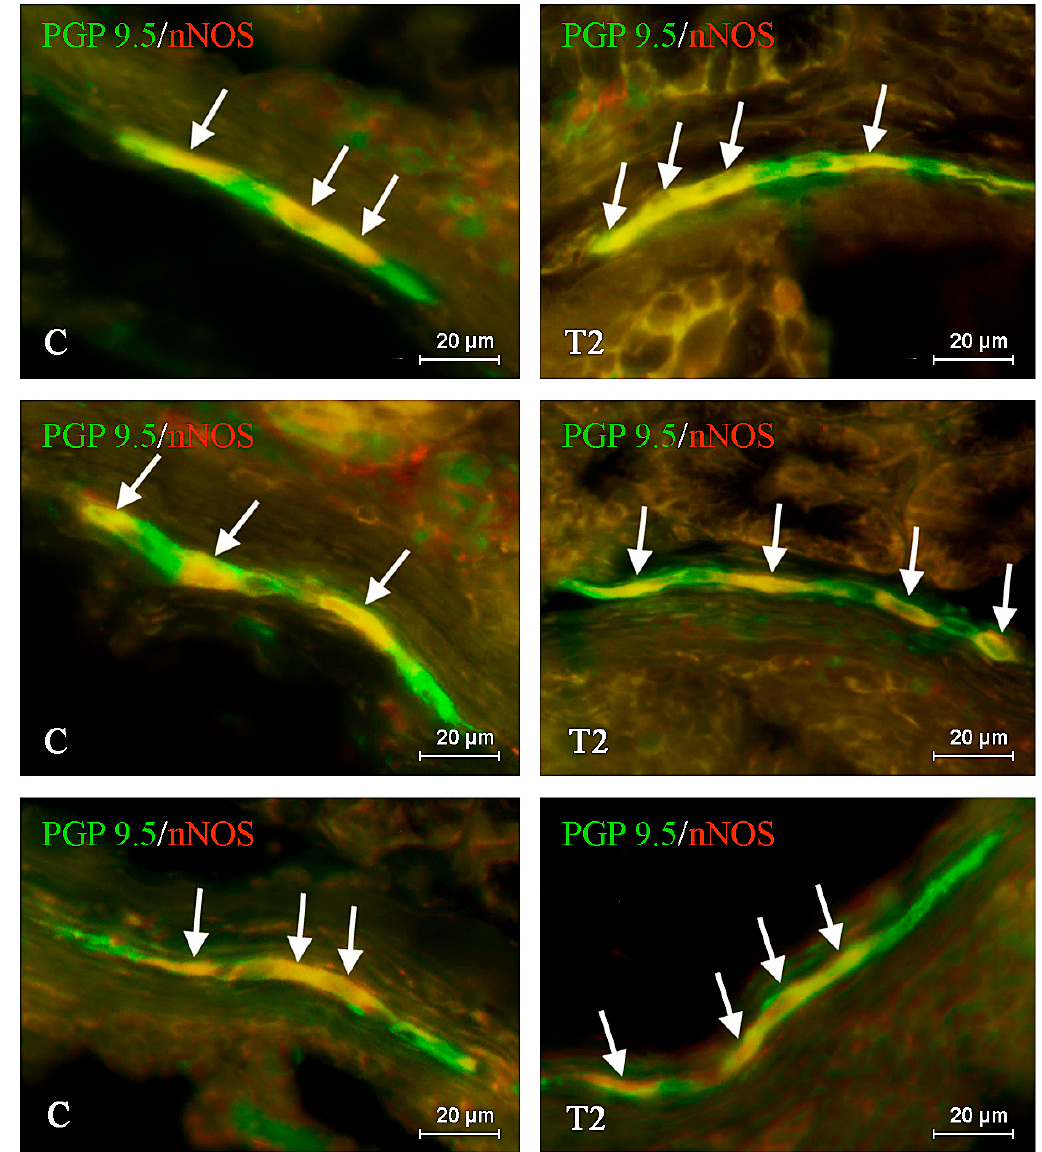
Figure 3. Distribution pattern of nerve cells immunoreactive to protein gene-product 9.5 (PGP 9.5)—used as pan neuronal marker and neuronal isoform of nitric oxide synthase (nNOS) in the inner submucous plexus of porcine duodenum under physiological conditions (C) and after T2-toxin administration (T2); the pictures are the result of the overlap of both stainings. The arrows are pointing neurons immunoreactive for both—PGP 9.5 and nNOS.